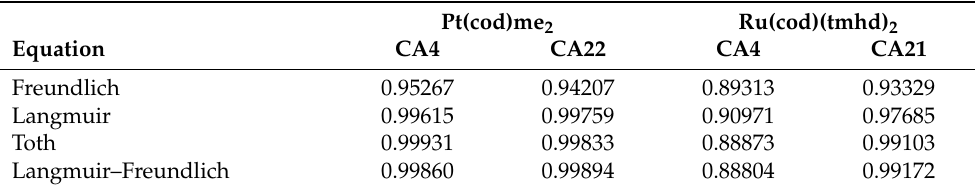
Table 1. Correlation parameters R 2 for selected adsorption isotherm